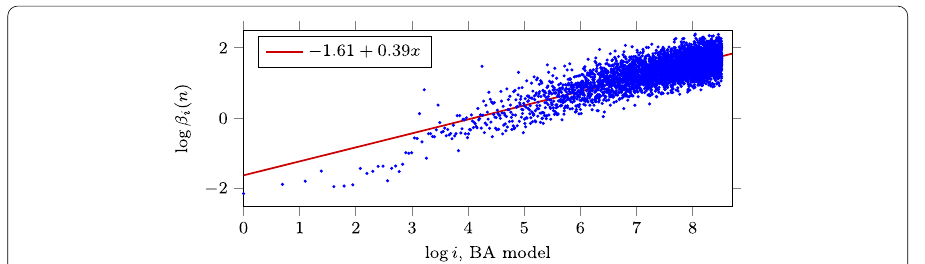
Fig. 7 The scattered log-log plot of points ( log i ,log β i ( n )) , where i is the iteration i = 1, ... ,5000 in which node v i appears and β i ( n ) is its friendship index evaluated at iteration n = 5000 , after simulating BA network of size n =